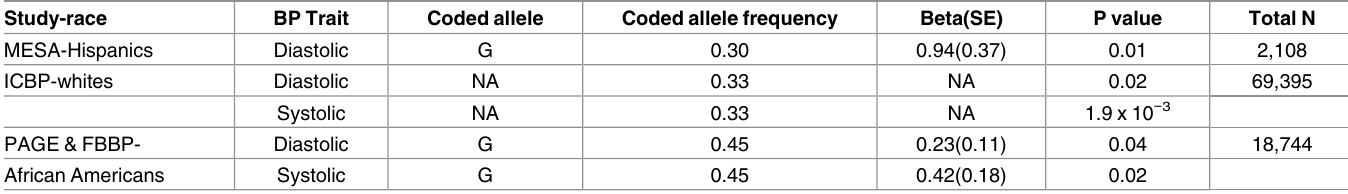
Table 3. Validation of the KCNK3 rs2586886associations with BP in independent multi-ethnic